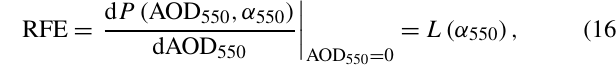
Figure 5a shows the dependence of DARE =